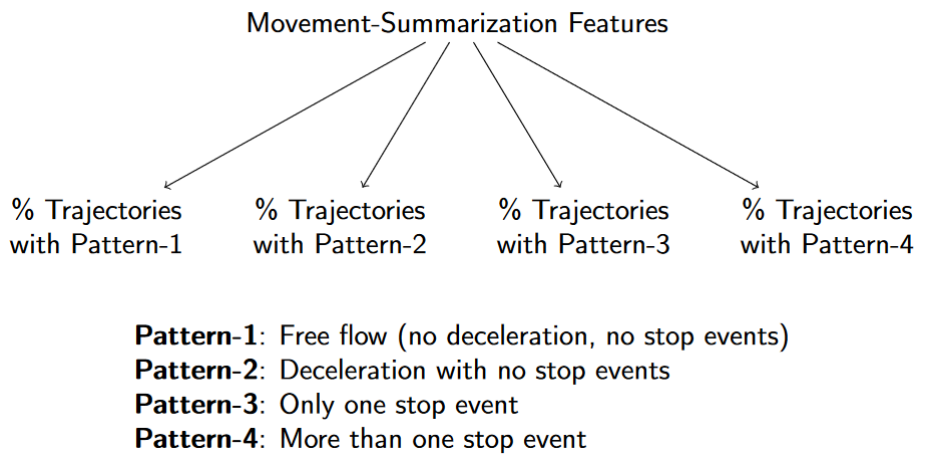
Figure 5. The four movement patterns that describe a vehicle’s crossing of a junction